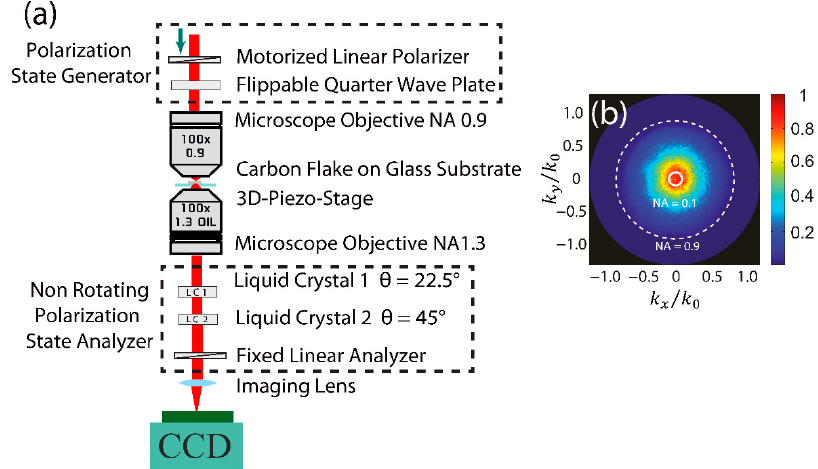
Figure 2. Experimental setup for the Mueller matrix measurement. ( a ) The polarization of the incident laser beam can be controlled (H, V, +45, − 45, right circular polarization (RCP), and left circular polarization (LCP) with a motorized polarizer and a quarter-wave plate. The incident beam is focused onto the sample (flakes on the glass substrate), which is placed on a piezo stage to raster-scan the flakes with respect to the fixed input beam. The transmitted light is collected with another objective and polarization analysis is performed using liquid crystals. The back focal plane of the lower objective is imaged onto the charge-coupled device (CCD) camera and recorded for further analysis. ( b ) During the analysis of the Fourier space image, only k-vectors corresponding to normal incidence (numerical aperture (NA) region 0.1) are used for extracting the Mueller matrix. The small focal spot size (on the order of the wavelength) ensures that no edge effects contribute to the results. The light is collected using an oil immersion objective of NA 1.3 (Leica HCX PL FL 100×/1.3 Oil, Leica Microsystems GmbH, Wetzlar, Germany). The collected light passes through a set of two liquid crystal cells and a fixed polarizer to perform a complete Stokes analysis fully characterizing the polarization state of light [32]. The Stokes vector 𝑆 can be calculated by projecting the incident light onto six polarization states (linear horizontal, vertical, diagonal, anti-diagonal as well as right- and left-handed circular).